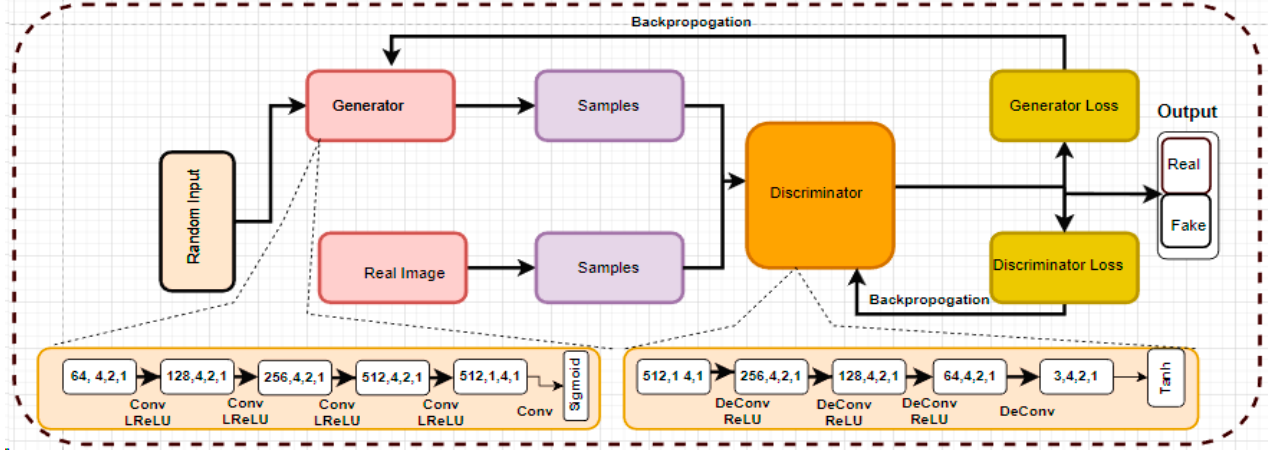
Figure 3. The architecture of DC ‐ GAN. The generator generates fake image samples and the dis ‐ criminator differentiates between a real image and a fake image.